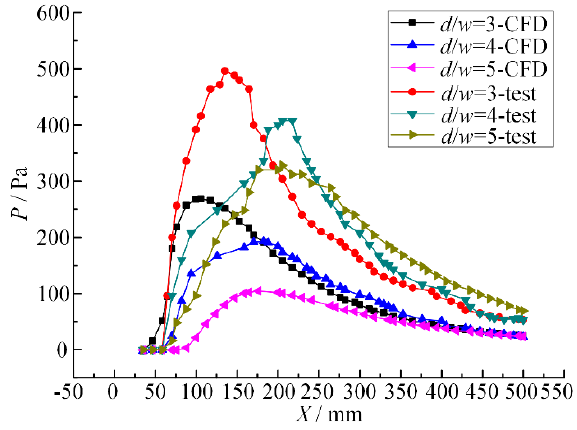
ff erent nozzle pitch ratios.